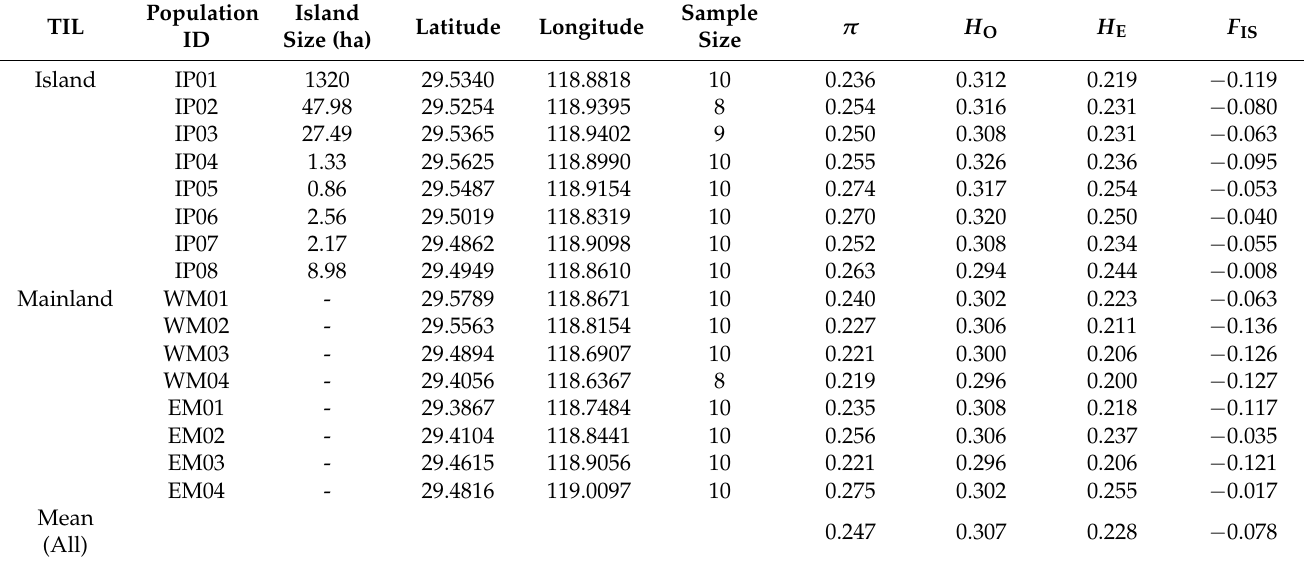
Table 1. Genetic characteristics of island and mainland populations of Hedyotis chrysotricha in the Thousand-Island Lake (TIL) region.